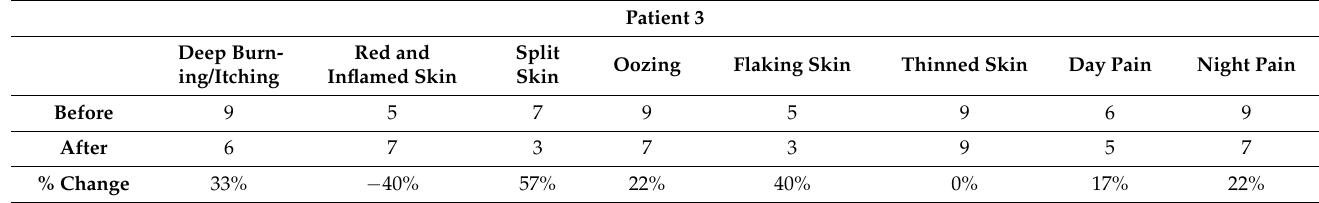
Table 5. Severity scores for Patient 3 before and after completing the study. The numbers in the table are out of ten, with ten being the worst severity, and zero meaning the symptom has ceased to exist. The percentage change in the severity of each symptom is shown in the bottom